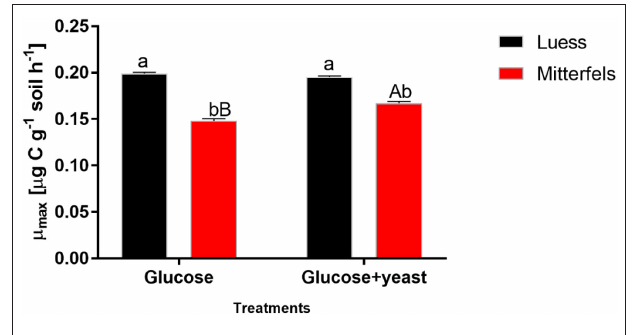
FIGURE 3 | Maximum specific growth rates including SEM of soil microorganisms after the addition of either glucose or the combination of glucose and yeast extract. Significant differences ( P < 0.05) between sites were denoted by lower-case letters. Capital letters denote significant differences between the substrate addition at identical level.